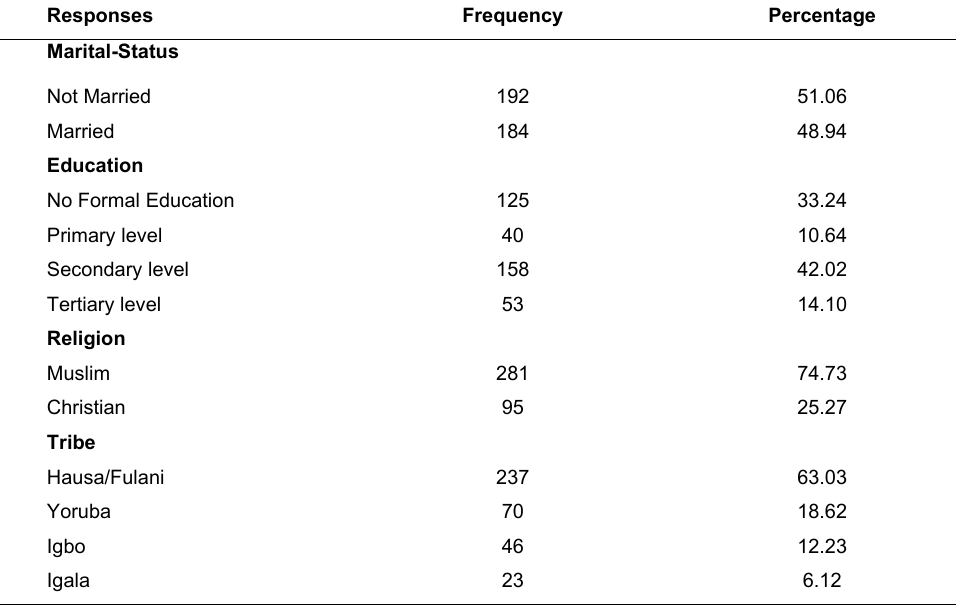
Table 1. Demographic and socio-economic